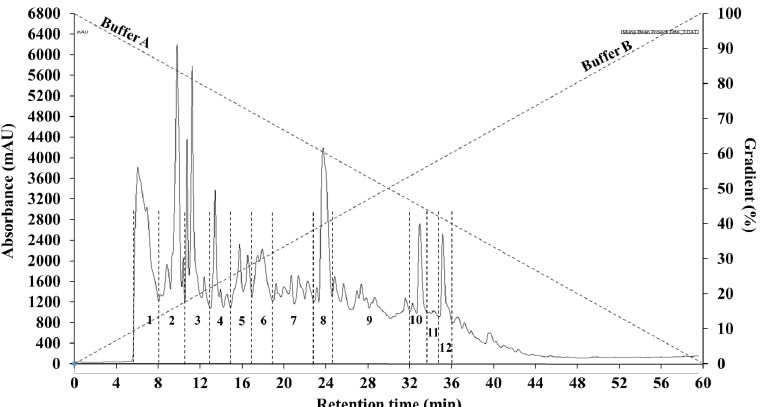
Figure 1. Initial separation of mung bean protein hydrolysate by reversed-phase (C12) HPLC into 12 fractions (1–12). Reprinted from Journal of Functional Foods , Vol. 64, Sonklin, C., Alashi, A.M., Laohakunjit, L., Kerdchoechuen, O., & Aluko, R.E. Identification of antihypertensive peptides from mung bean protein hydrolysate and their effects in spontaneously hypertensive rats, Article 103635. Copyright (2020), with permission from Elsevier. The principle of the RP-HPLC involves separating peptides based on their differ- ences in hydrophobicity (hydrophobic/hydrophilic characters). The hydrophilic peptides were eluted first while the more hydrophobic peptides become eluted later. The twelve peptide fractions were assayed for their antioxidant activities using five different methods including DPPH radical scavenging activity, hydroxyl radical scavenging activity, super- oxide radical scavenging activity, FRAP, and metal chelating activity (Figure 2).